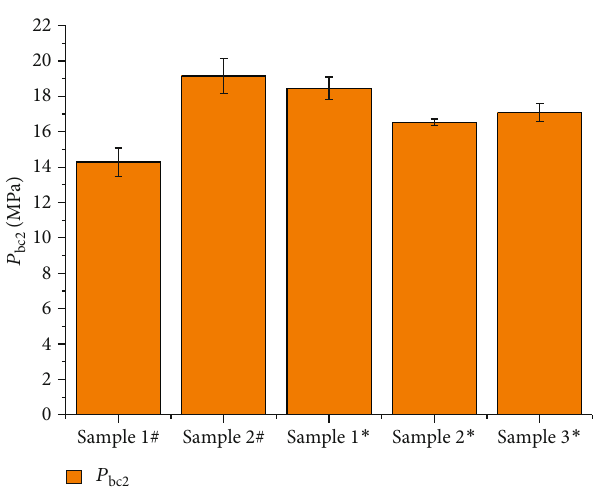
Figure 7: E ff ect of PVAGB and/or FLA A to cement-based material (FTIR). C: pure samples; C-S: samples with dispersant SXY-2; C-S/FLA A: samples with dispersant SXY-2 and additive FLA A; C-S/FLA A/PVAGB: samples with dispersant SXY-2 and additives FLA A and